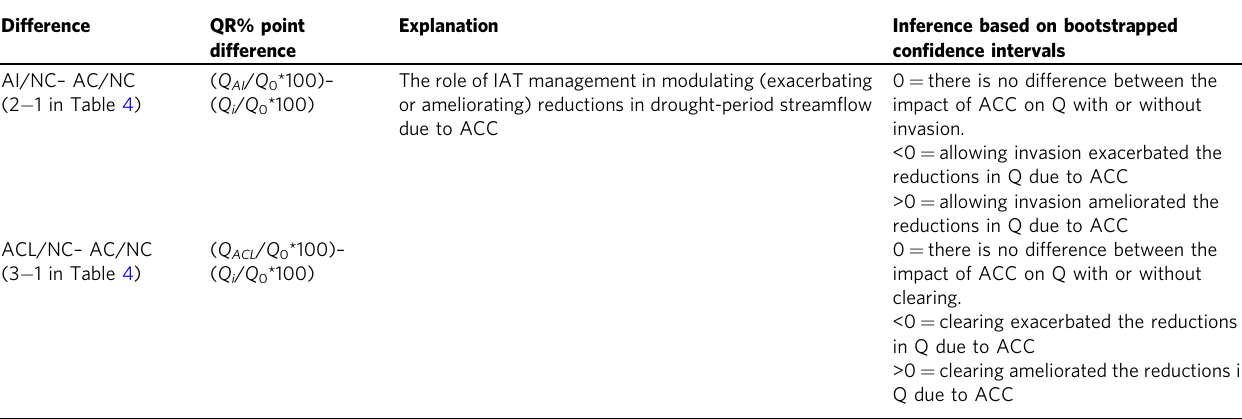
Table 5 Formulae used to calculate the percentage point difference between the QR% for the paired climate-IAT states to show potential of invasive alien tree (IAT) management in modulating the impact of anthropogenic climate change on drought-period stream fl ow in South